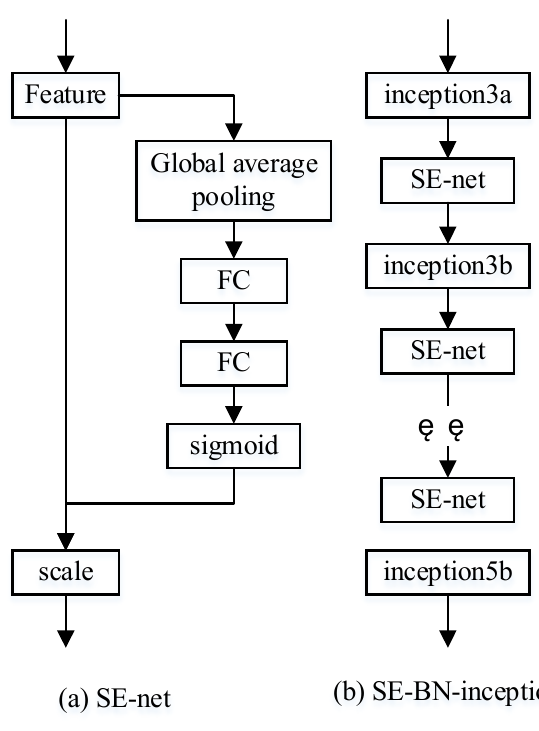
Figure 2. Structure of SE-net and SE-BN-inception